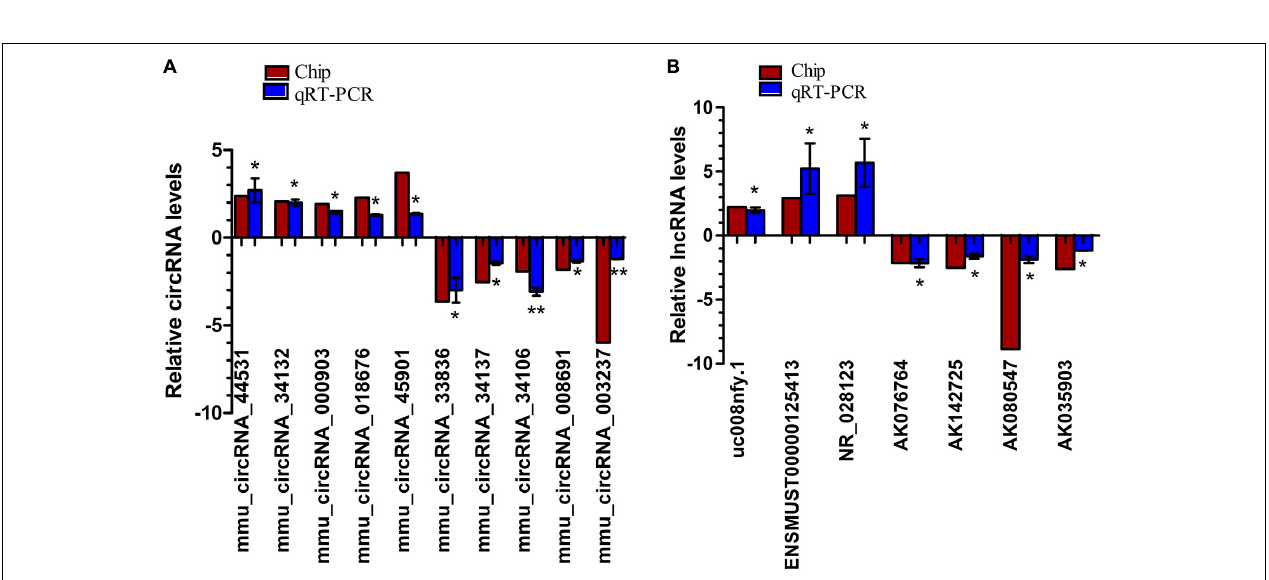
FIGURE 4 | QRT-PCR validation of the expression levels of candidate circRNAs (A) and lncRNAs (B) . ∗ p < 0.05 and ∗∗ p < 0.01. The deep red column indicates the expression status of lncRNAs through microarray analyses; the blue column indicates the expression status of lncRNAs through qRT-PCR experiments. n = 3.